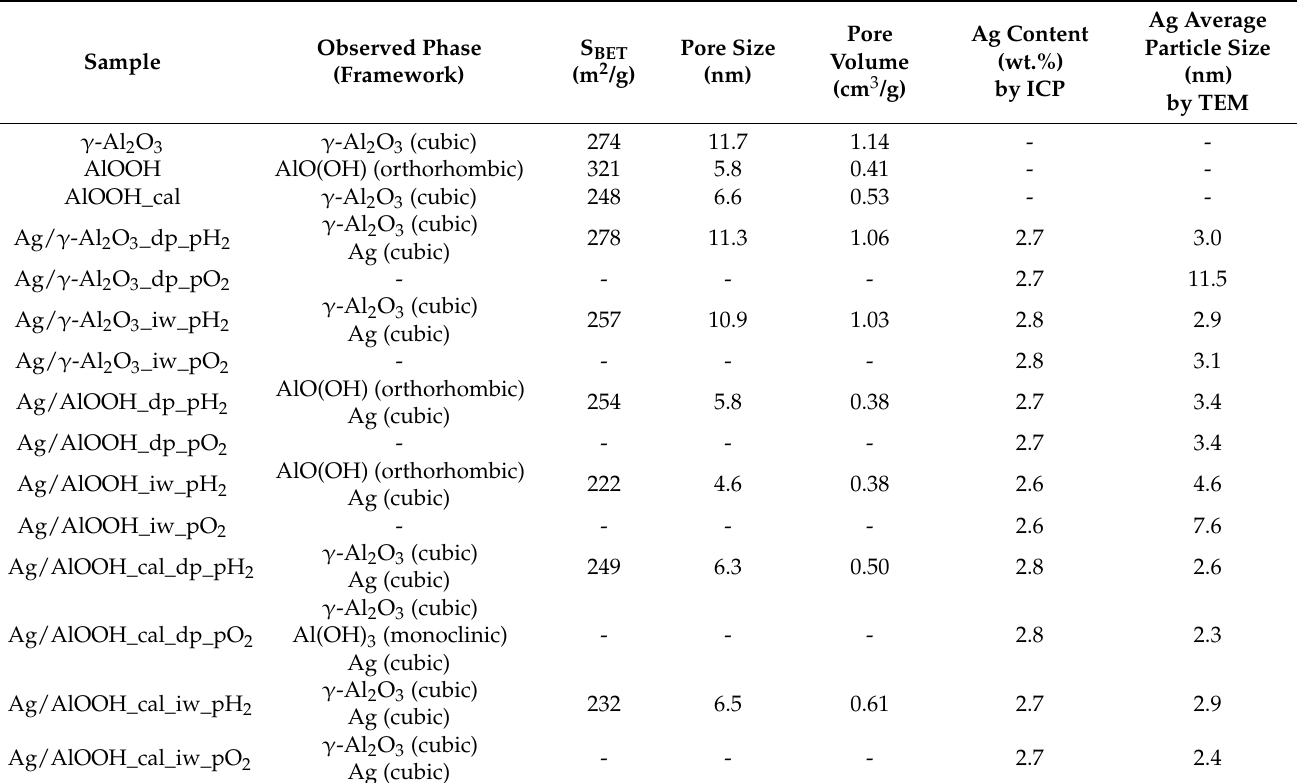
Table 1. Structural and textural characteristics of the studied supports and the corresponding silver catalysts, Ag content and the average Ag particle